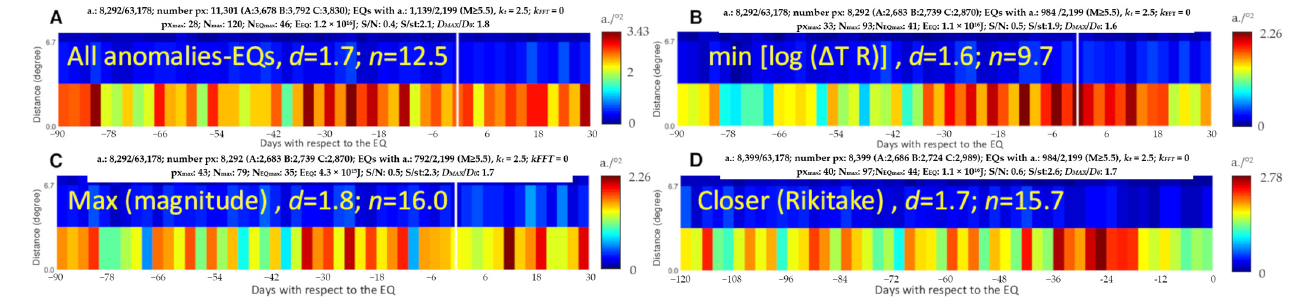
Figure 1. Correlation of Swarm magnetic field anomalies with M5.5+ earthquakes using four different methods: ( A ) all anomalies are associated with all compatible earthquakes; ( B ) each anomaly is associated with the closest earthquake in space and time, i.e., the minimum of log( Δ T R); ( C ) the anomaly is associated with the greatest magnitude earthquake; ( D ) the anomaly is associated with the earthquake closer to the Rikitake law, with coefficients from De Santis et al. [29]. The graphs are cut for the vertical section without significant information, showing only the closer band to the earthquake epicenter. The color bar represents the density of anomalies in terms of the number of anomalies per square degree.